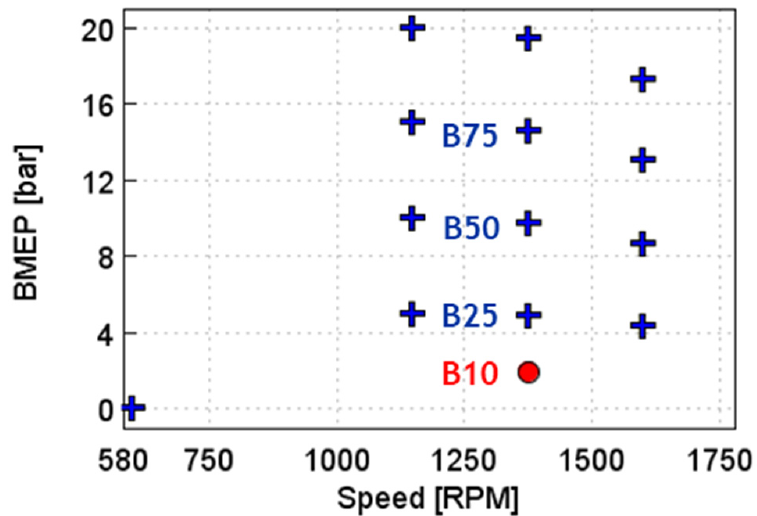
Figure 2. The 13-mode non-idle SET cycle. The investigated B10 condition is highlighted in red.